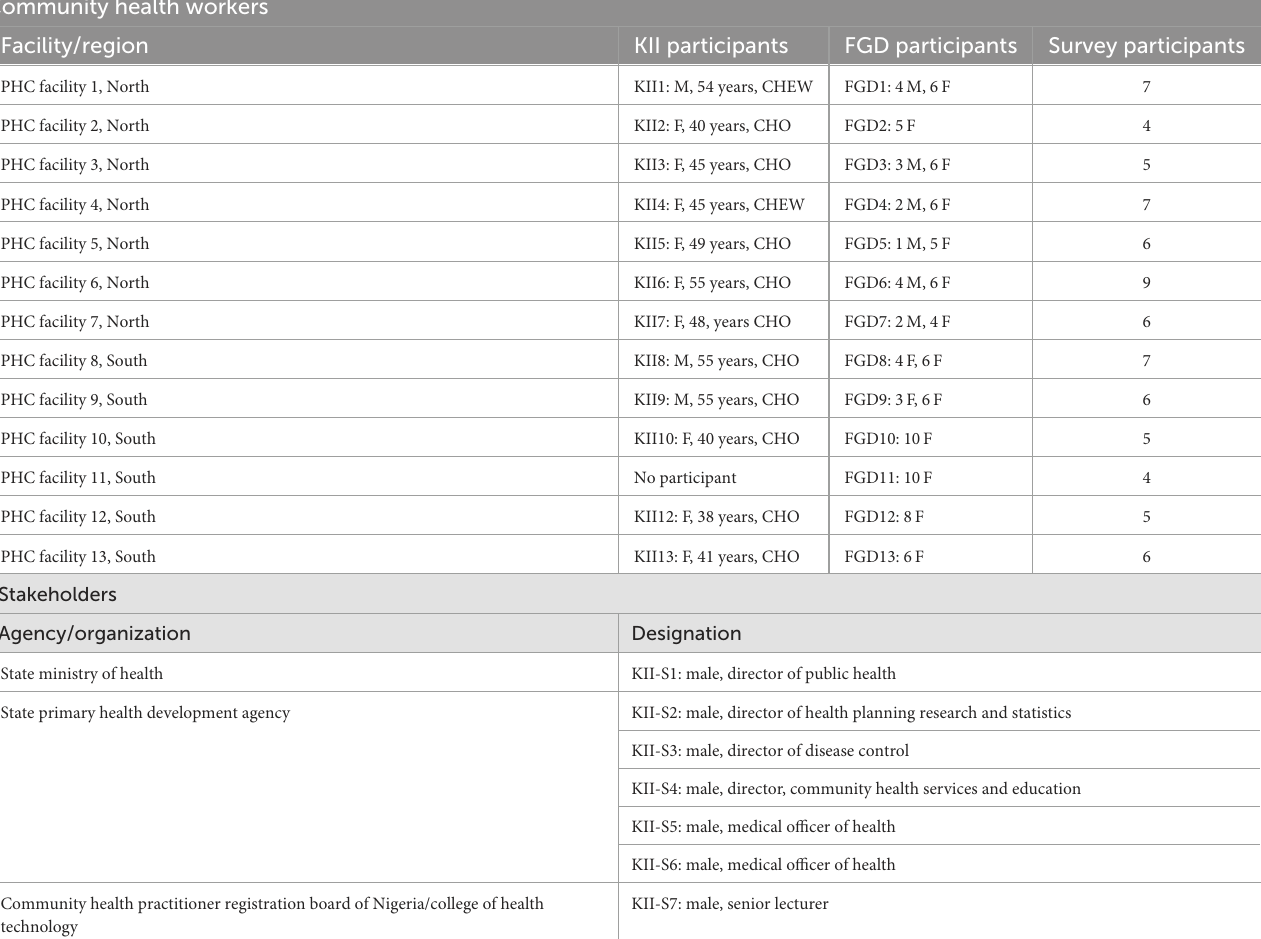
TABLE 3 Interview and survey participants. Community health